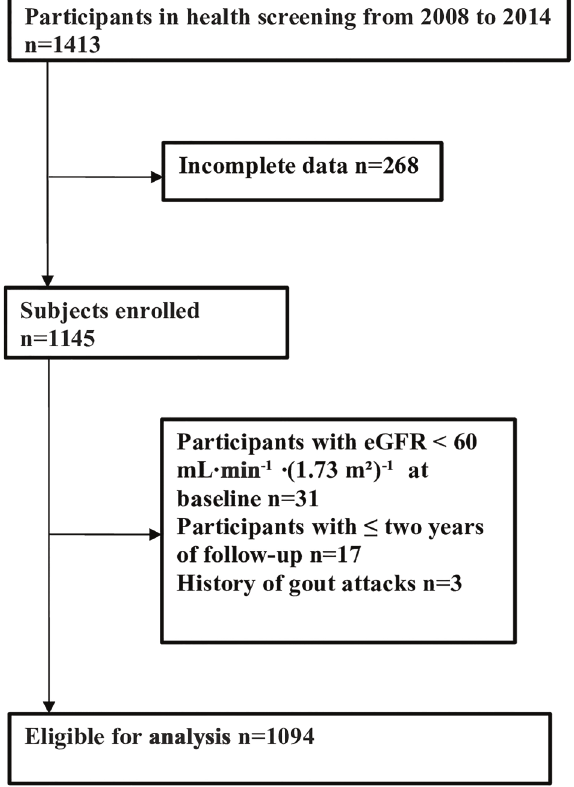
Figure 1. Selection of study